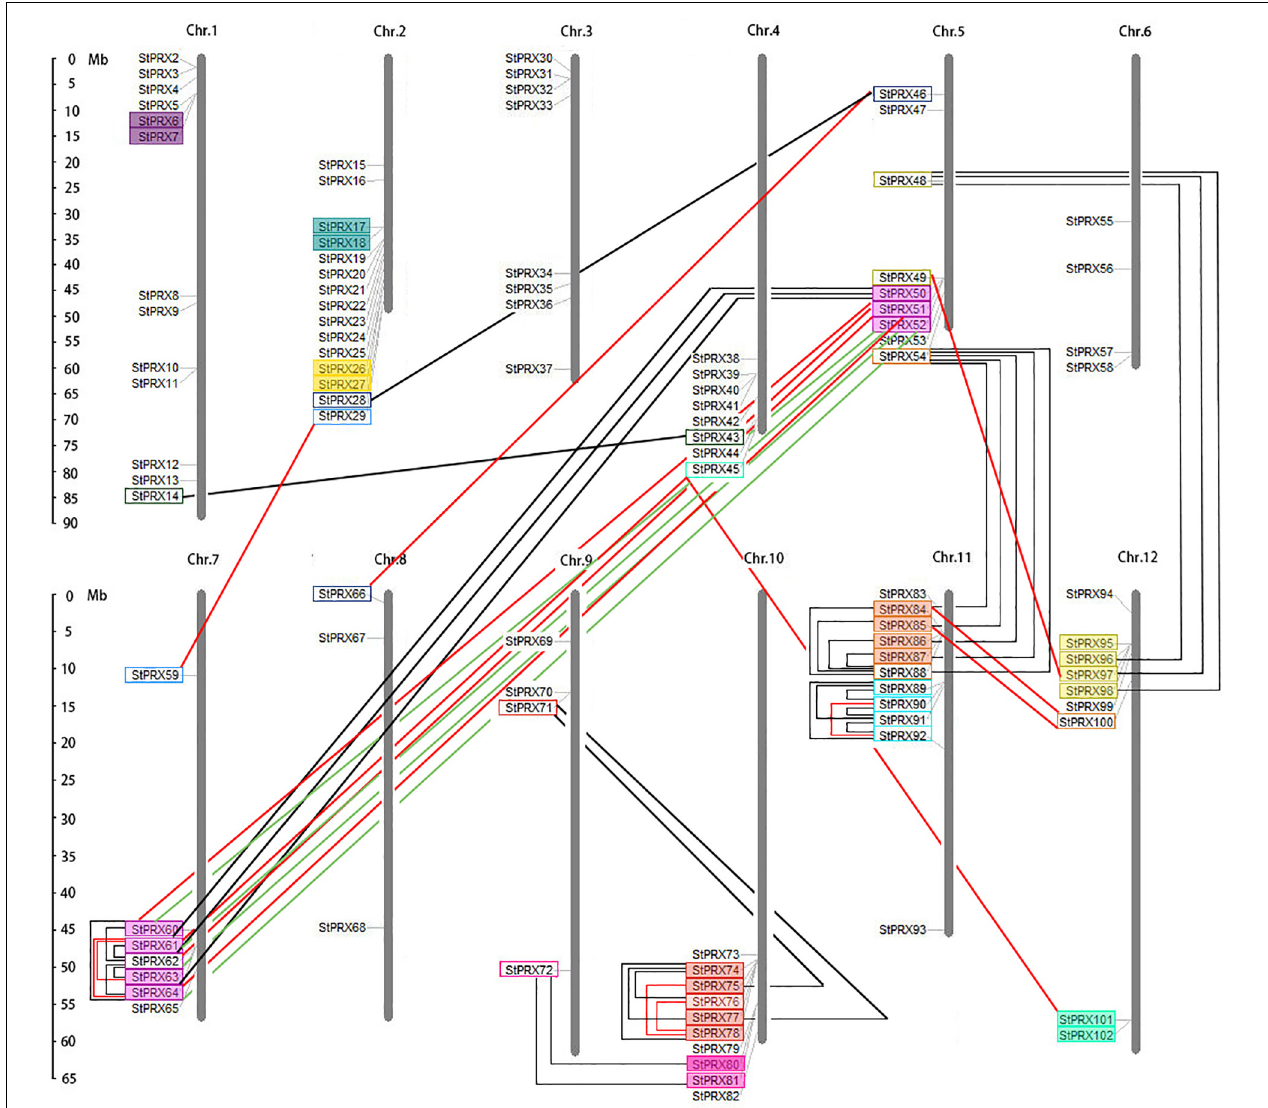
FIGURE 4 | Chromosomal locations of potato PRX genes. The scale on the left presents the length of potato chromosomes (Mb). Tandem duplicated gene pairs are displayed with boxes of the same color. Segmented duplicated gene pairs are displayed with boxes connected by